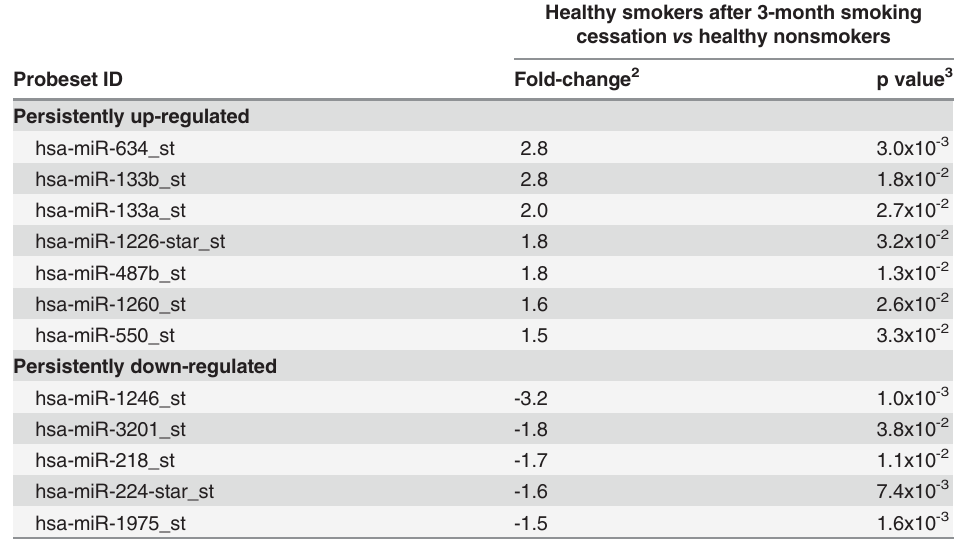
Healthy smokers after 3-month smoking cessation vs healthy nonsmokers